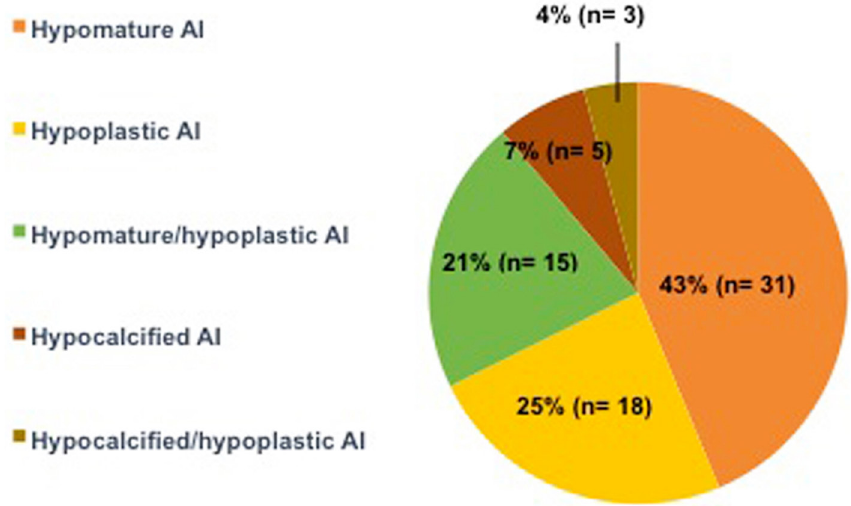
Figure 1- Pie chart showing the distribution of clinical subtypes in the 72 patients affected with Amelogenesis